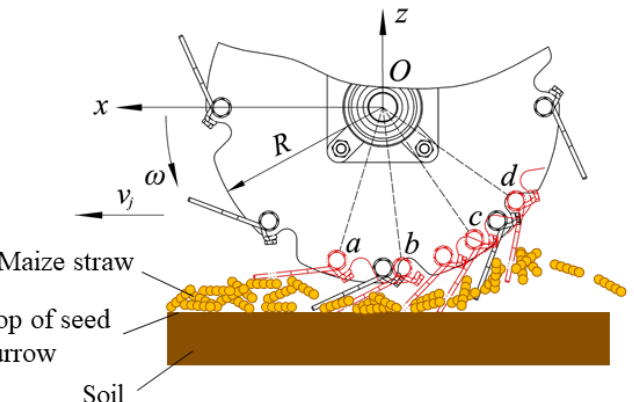
Figure 6. The movement process of seed furrow clearing. The functions of a–d are described in the